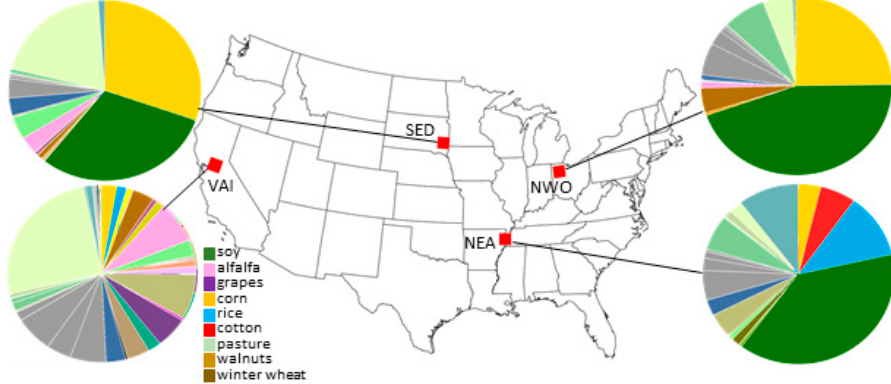
Figure 1. The four diverse case study sites located in major production hot spots in the USA with varying bioclimates, calendars, and managements. varying bioclimates, calendars, and